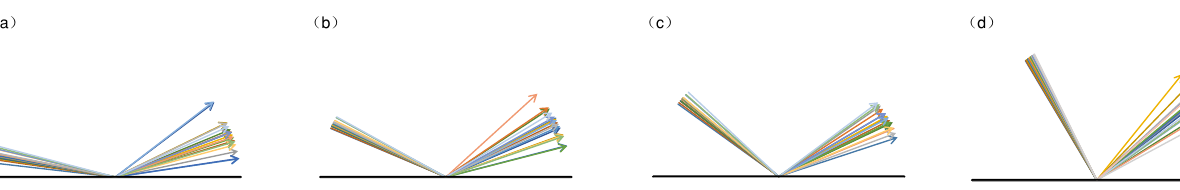
Figure 9. Direction transitions of translational velocities induced by impacts under different impact angle conditions: (a) 6 ◦ <α < 15 ◦ ; (b) 23 ◦ <α < 30 ◦ ; (c) 36 ◦ <α < 44 ◦ ; (d) 55 ◦ <α < 60 ◦ .